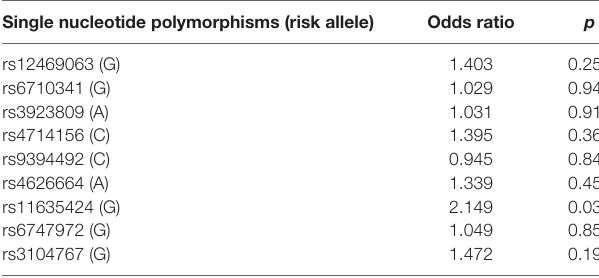
TaBle 3 | Associations between allele frequency and RLS. a